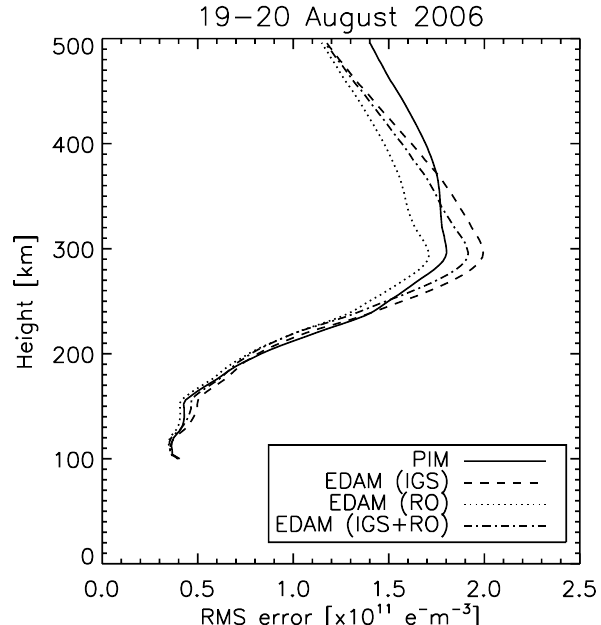
Fig. 6. RMS error between ionospheric models and ionosonde ver- tical profiles at 5km height steps on 19–20 August 2006 (disturbed geomagnetic conditions). The models are: PIM (solid line); EDAM assimilating IGS data only (dashed line); EDAM assimilating COS- MIC RO data only (dotted line); and EDAM assimilating IGS and COSMIC RO data (dot-dash line).